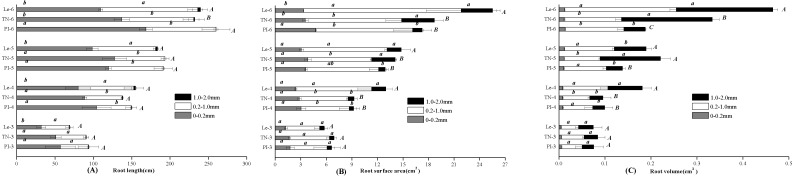
Total value of root length (A), root surface area (B), and root volume (C) in the fine-root diameter range of 0–0.2, 0.2–1.0 and 1.0–2.0 mm of three rice cultivars (PI and TN, allelopathic cultivars PI312777 and Taichung Native1; Le, non-allelopathic cultivar Lemont) at 3–6 leaf stages.Significant differences (P < 0.05) between rice cultivars at the same leaf stage were indicated by different lowercases, and the significant differences for total values of 0–2.0 mm diameter were indicated by different uppercases at the end of the bars, according to Tukey’s honestly test.